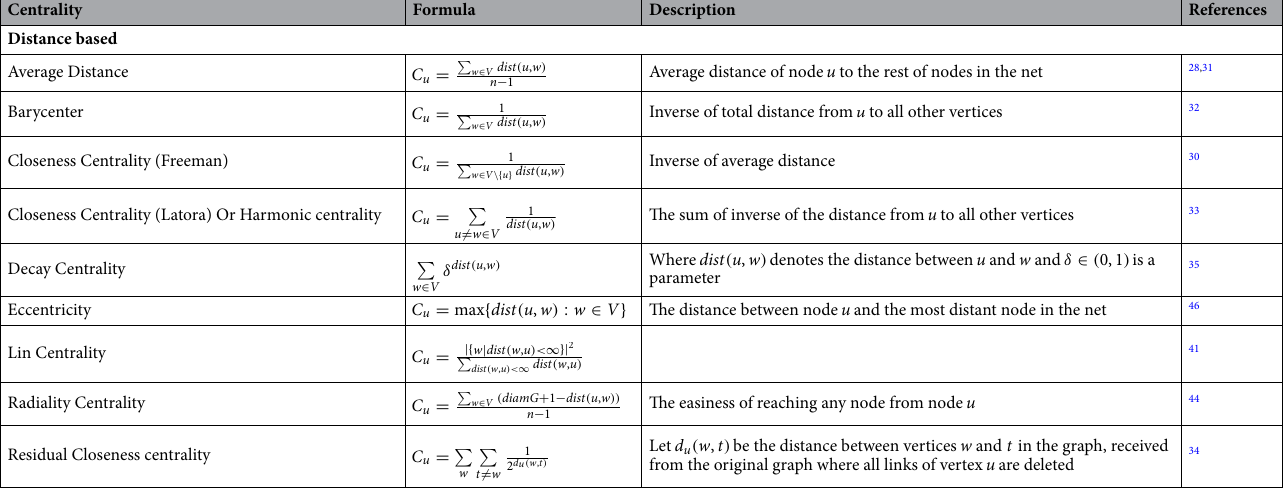
Table 2. Definitions for distance based centrality